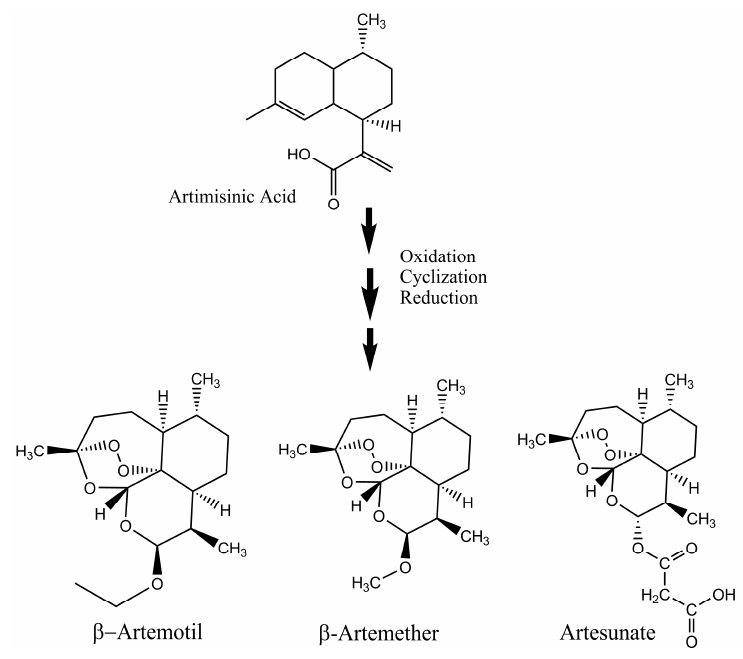
Figure 4. Production of active derivatives of artemisinin from artemisinic acid.